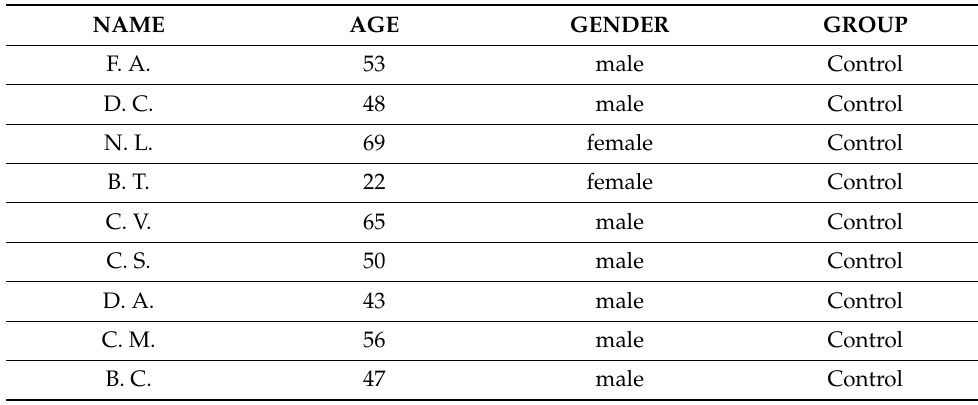
Table 1. Demographic data of